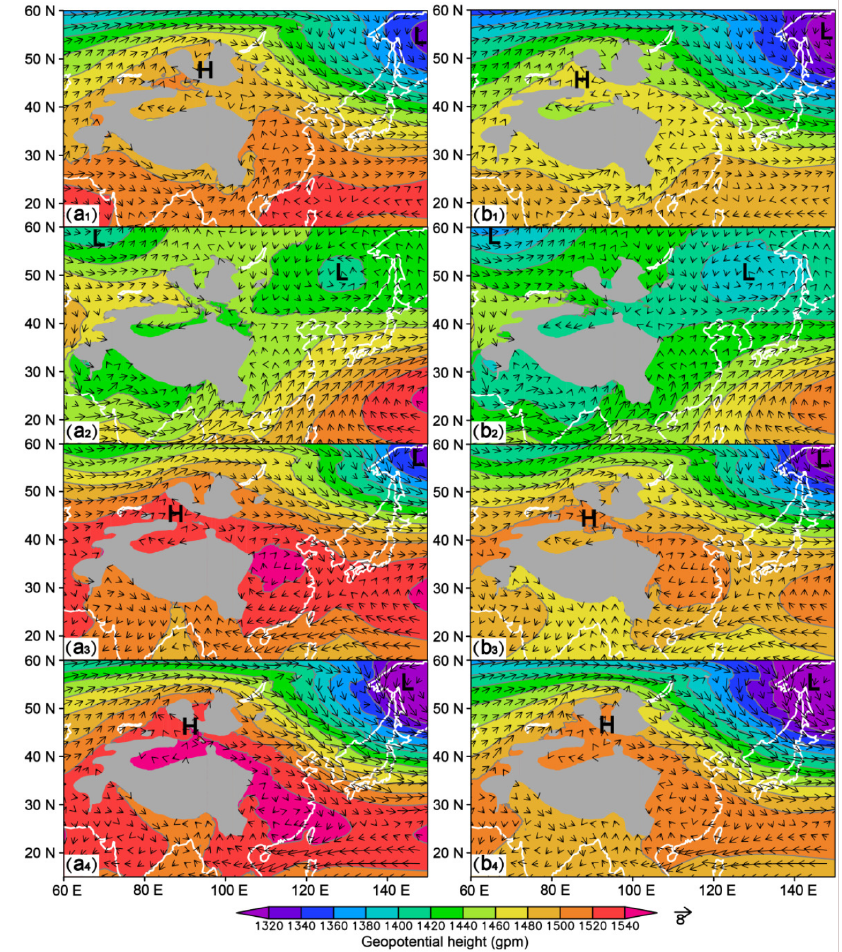
Figure 3. ECMWF-predicted ( a 1 – a 4 ) and reanalyzed ( b 1 – b 4 ) 850 hPa geopotential heights (shaded; units: gpm) and wind vectors (units: m · s − 1 ) of March ( a 1 , b 1 ), June ( a 2 , b 2 ), October ( a 3 , b 3 ), and December ( a 4 , b 4 ) averaged over the three years (2016–2018). H and L stand for the centers of high and low geopotential heights, respectively. The Qinghai-Tibet Plateau and the Mongolian Plateau are